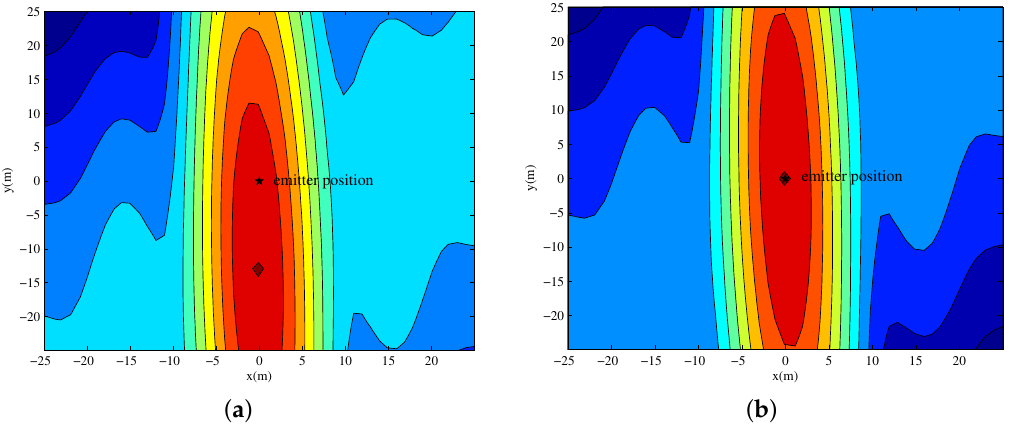
Figure 6. The filled 2D contour plot of the noise-free spectrum. ( a ) the filled contour plot of D-DPD’s spectrum; ( b ) the filled contour plot of DDR-DPD’s spectrum.